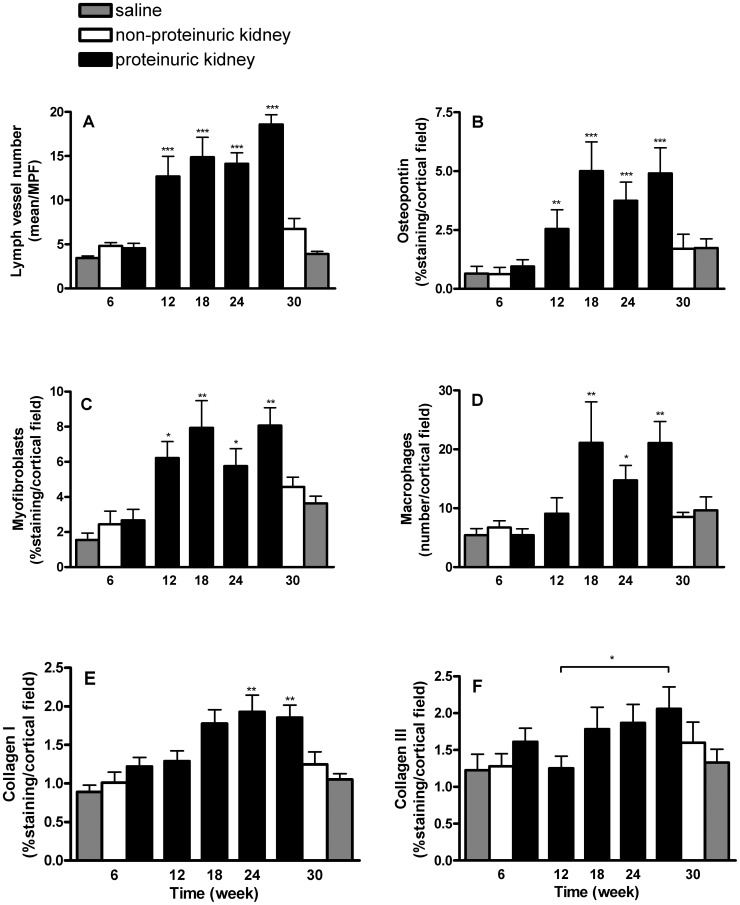
Quantitative immunohistochemical analysis of tubulo-interstitial damage markers in proteinuric, non-proteinuric and saline-injected rats over time.Lymphangiogenesis (A), measured as lymph vessel number per medium power field (MPF/200×); osteopontin staining (B), quantified as % positive staining per cortical field; myofibroblasts (C), quantified as % positive staining for α-smooth muscle-cell actin per cortical field; interstitial (ED-1)-positive macrophages (D), numbers per cortical field; interstitial collagen type I deposition (E), quantified as % staining per cortical field; and interstitial collagen type III deposition (F), quantified as % staining per cortical field (*p<0.05, **p<0.01, ***p<0.001 versus week 6, and for collagen III only week 12 versus week 30 was significant).